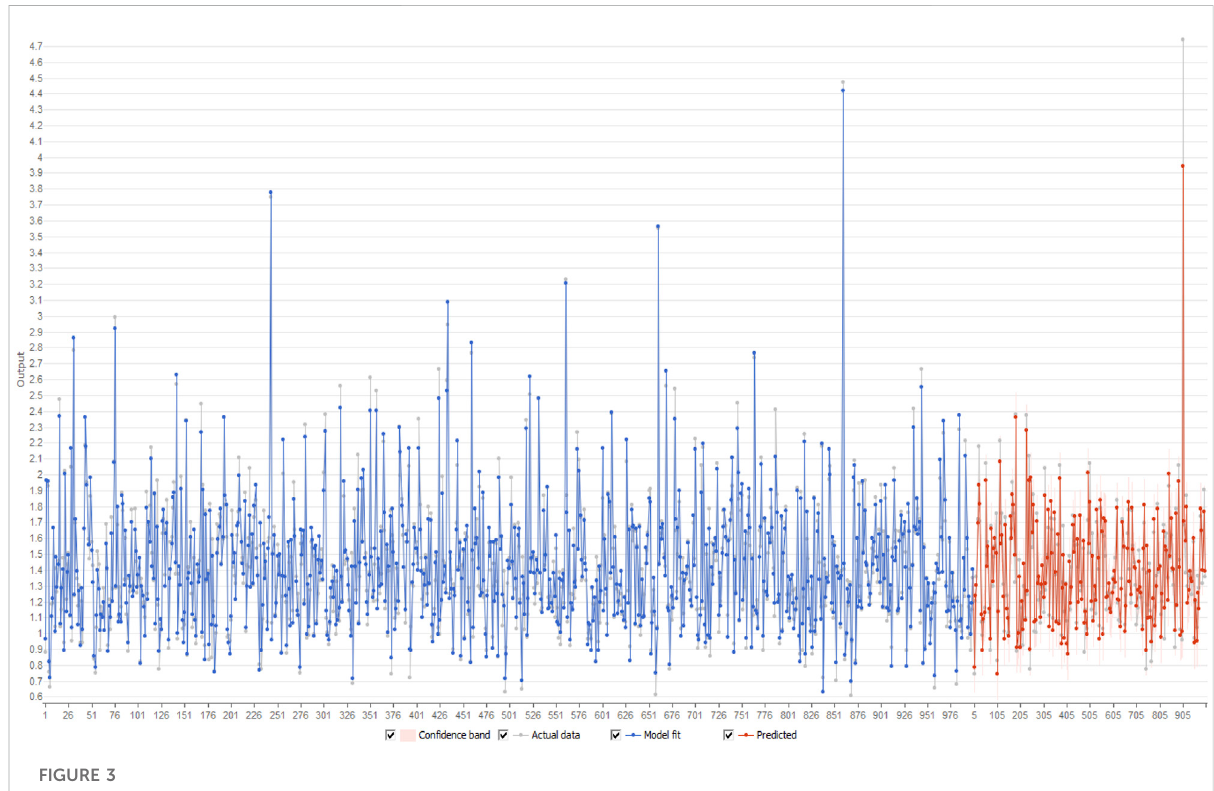
FIGURE 3 Figure showing the distribution of residuals derived from observed and predicted output for #21ANG1.